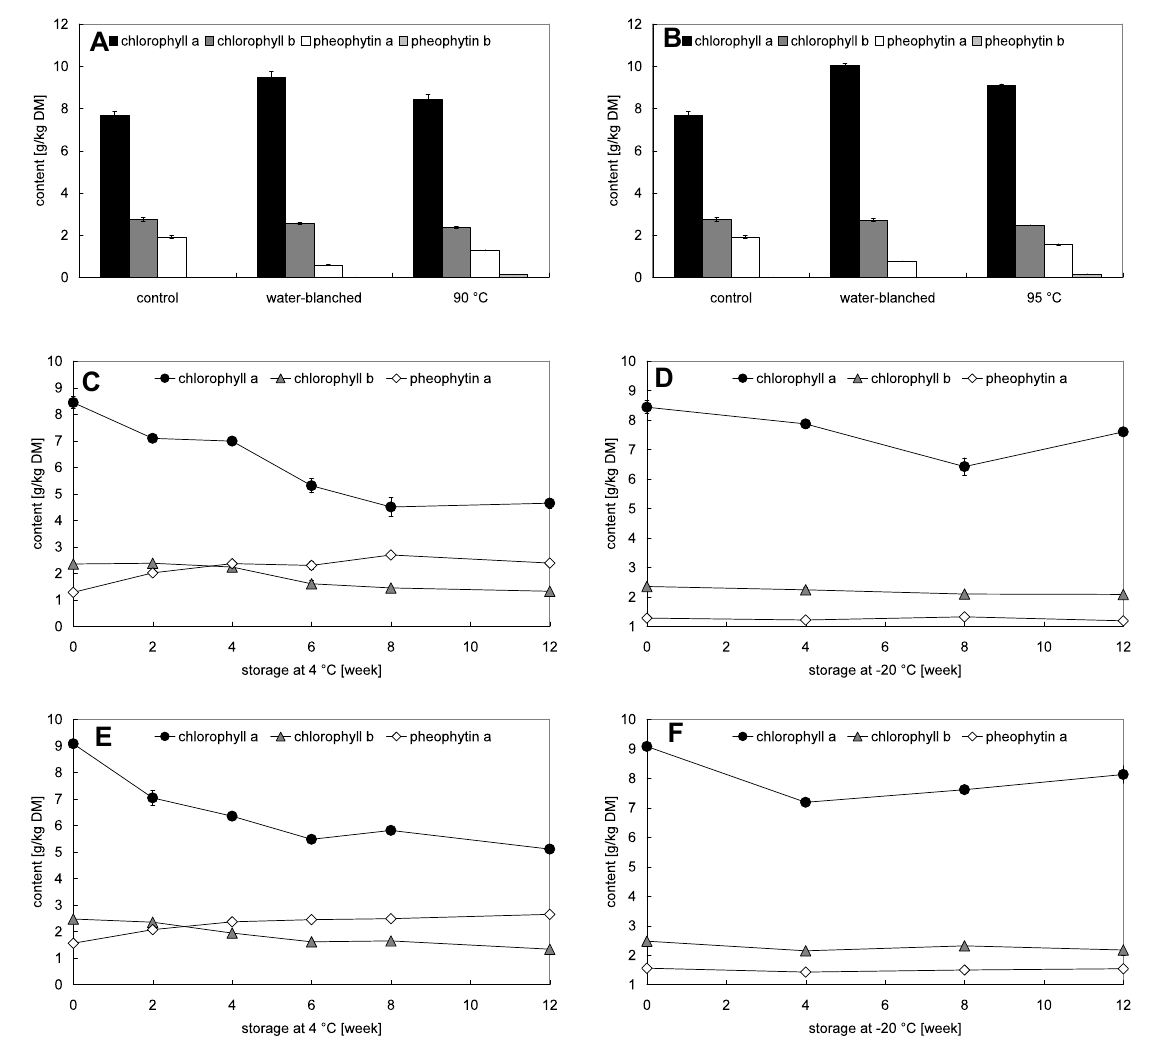
Fig. 1: Chlorophyll and pheophytin contents during processing (A, B) and 12 weeks of storage (C-F) at 4 and -20 °C of parsley pastes: (A) processing at 90 °C, (B) processing at 95 °C, (C) storage at 4 °C of the pastes processed at 90 °C, (D) storage at -20 °C of the pastes processed at 90 °C, (E) storage at 4 °C of the pastes processed at 95 °C, (F) storage at -20 °C of the pastes processed at 95 °C. Columns and bars represent mean ± standard deviation (n =